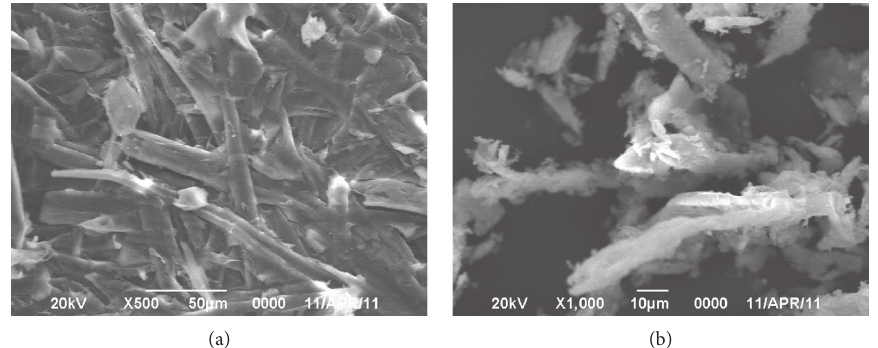
Figure 7: Surface morphology of phenolic resin before and after crushing. (a) Phenolic resin raw material ( × 500 times). (b) Phenolic resin powder with 200 mesh ( × 1000 times).